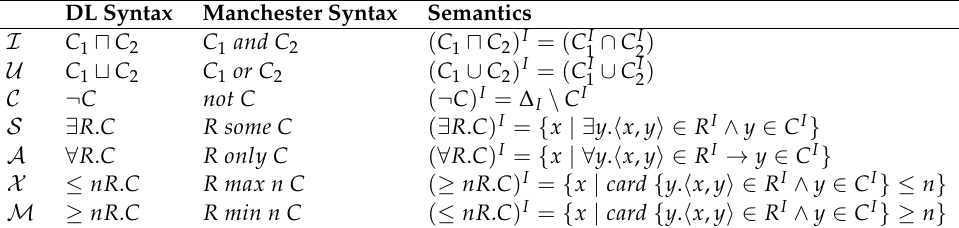
Table 1. Semantics of the OWL logical operators. DL, Description